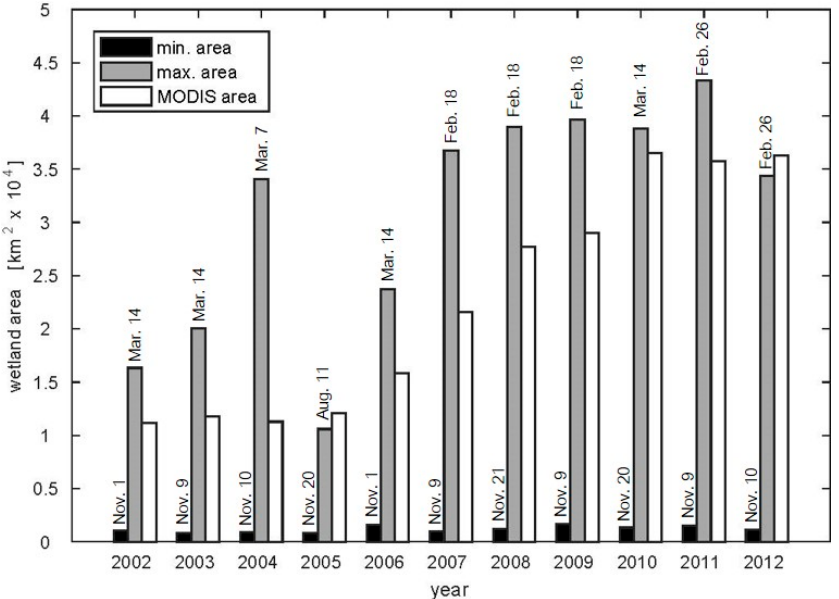
Figure 5. Bar graph showing the annual variability in wetland area. The minimum (black) and maximum (gray) wetland areas for each year are displayed alongside the wetland area from the annual MODIS MCD12Q1 product (white). The dates for the minimum and maximum areal extents are displayed above their respective bars.